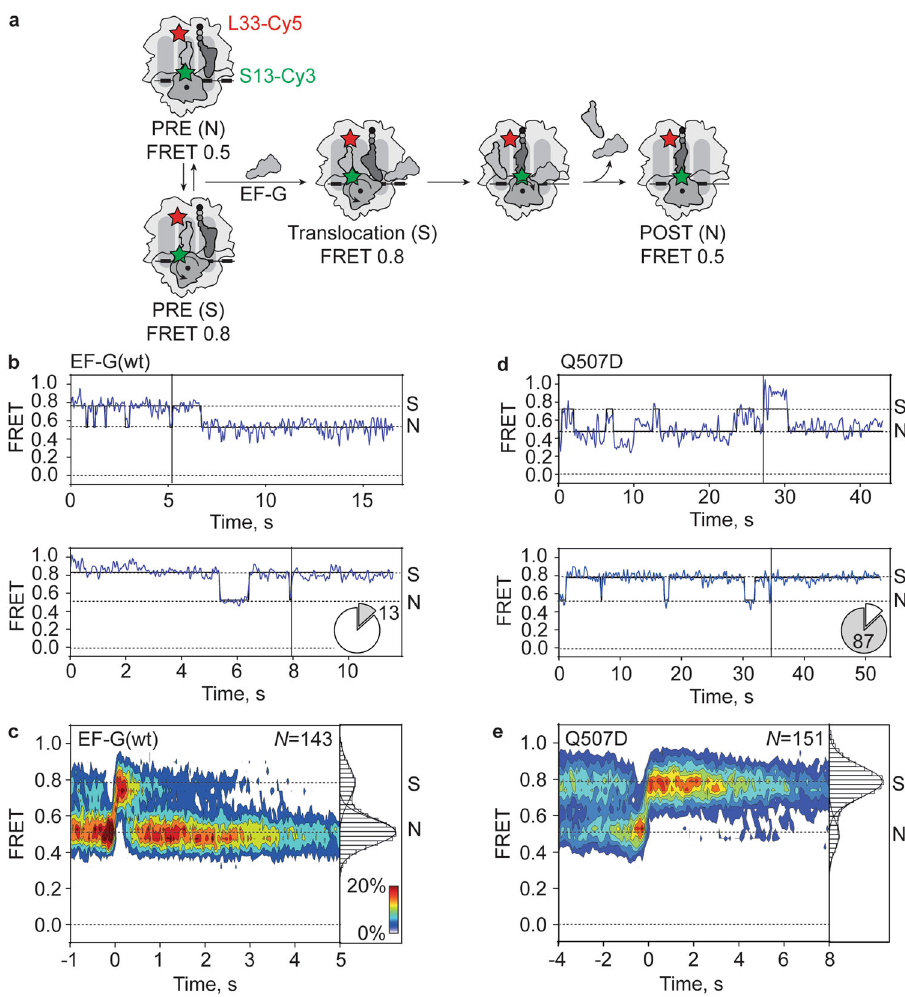
Fig. 6 SSU head domain swiveling during translocation on slippery mRNA. a Schematic of smFRET experiment. Movement of SSU head domain during translocation induced by addition of EF-G to immobilized PRE complexes monitored with FRET labels on ribosomal proteins S13 (S13-Cy3, green star) and L33 (L33-Cy5, red star). FRET values representing the non-swiveled (N) and swiveled (S) states are determined in independent experiments (Supplementary Fig. 9 and Table 3). b Representative smFRET time traces for SSU head movements during EF-G(wt)-induced translocation. The majority of traces (upper panel) show fl uctuations between FRET 0.8 (S) and 0.5 (N) followed by a stable FRET 0.5 (N) state after translocation. 13% of traces (lower panel) show no transition to the N state in the time course of the experiment. Pie charts indicate the percentage of traces ending in N (white) or S (gray) state. Black vertical lines represent the synchronization point, i.e., the last transition to FRET 0.8 (S) (see below). c Contour plot showing distribution of FRET values representing SSU head movement during translocation on slippery mRNA by EF-G(wt). Traces were synchronized to the last transition to FRET 0.8 (S). The duration of the last FRET 0.8 state is an estimate for the duration of translocation, because back swiveling occurs simultaneously with the dissociation of EF-G from the ribosome after translocation 38 . Histogram at the right shows distribution of FRET values after synchronization. Data are from four independent experiments ( N = 4). d Representative smFRET time traces for SSU head domain movement during translocation on slippery mRNA with EF-G(Q507D). A small fraction of traces (upper panel) show fl uctuations between FRET 0.8 (S) and 0.5 (N) and end in a stable FRET 0.5 (N) state after translocation. 87% of traces (lower panel) show no transition to the N state in the time course of the experiment. e Contour plot showing distribution of FRET values representing SSU head domain movement during translocation on slippery mRNA by EF-G(Q507D). Histogram at the right shows the distribution of FRET values after synchronization. Data are from three independent experiments ( N = on E. coli dnaX mRNA using optical tweezers showed that stalled ribosomes make multiple translocation attempts sampling sequences upstream or downstream of the 0 frame 61 . In our study, fl uctuations of pept-tRNA between CHI and P/P states allow ribosomes to explore alternative reading frames and eventually re-equilibrate in a reading frame that is thermo- dynamically favored before resuming translation. The difference between the spontaneous slippage and – 1PRF concerns the timing of deacylated tRNA release, which is rapid during spontaneous frameshifting (this paper and ref. 16 ), but slow in